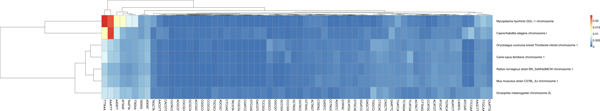
Length-6 palindromic spectrum set. Here we note that this tree does not conform well to the validation tree in Figure 14. Rat and mouse are shown to be closely related but inaccurately, the tree shows that the bacterium and the worm are also closely related.